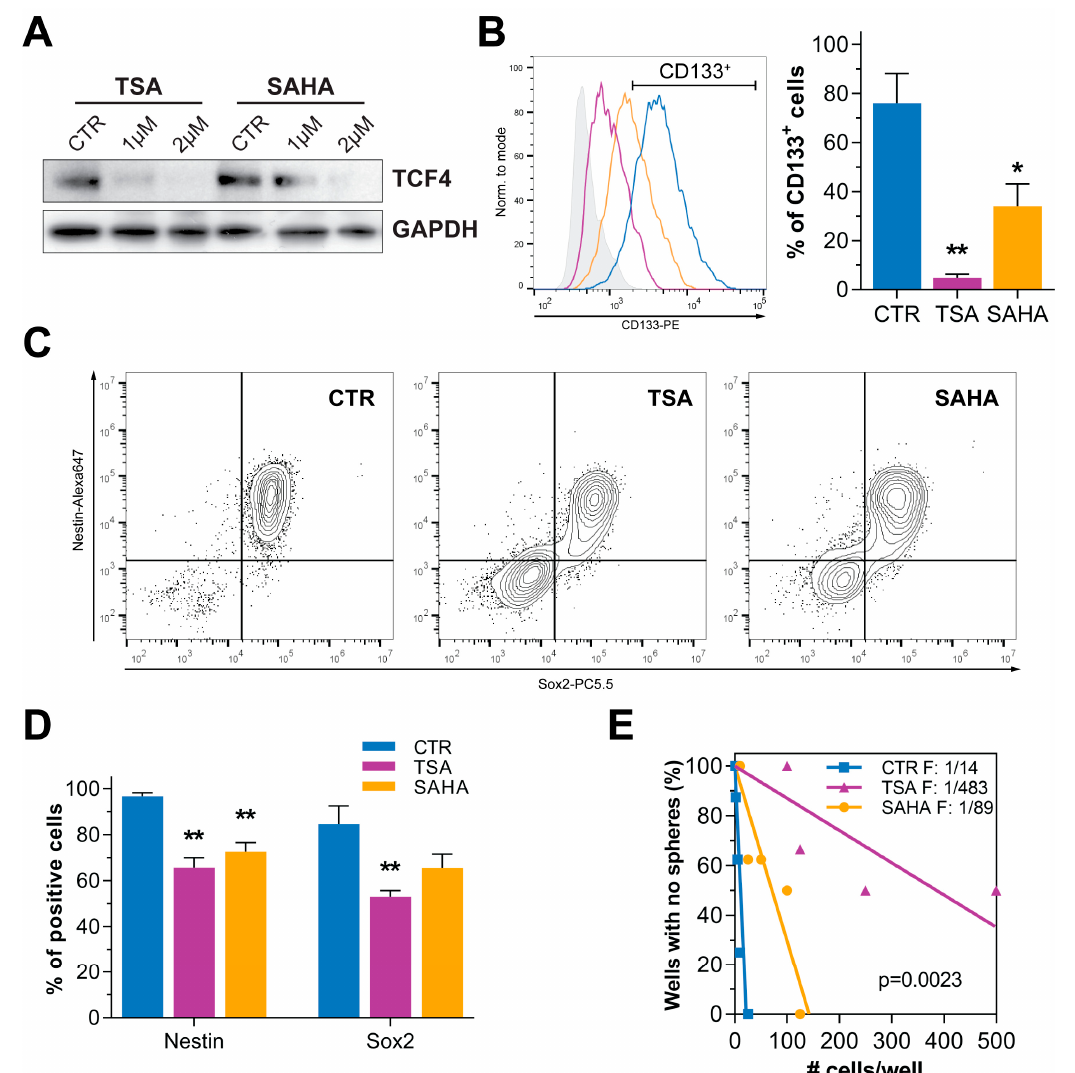
Figure 1. HDI treatment reduces TCF4 levels and impairs CSC phenotype and self-renewal. ( A ) West- ern blot analysis displaying TCF4 protein levels upon TSA and SAHA exposure (1–2 µ M) for 24 h (HuTuP53). GAPDH was used as loading control. The original Western blot images included in ( A ) are provided in Supplementary Figure S1A. ( B ) Representative CD133 surface expression in control and TSA (1 µ M)/SAHA (2 µ M) treated GBM cells (72 h; HuTuP197) (left) and graph sum- marizing quantification of CD133+ cells in 3 primary GBM cultures (mean of HuTuP13, 176, and 197) (right). ( C , D ) Representative contour plots displaying the combined expression of Nestin and Sox2 in HuTuP197 cells after 72 h of treatment with TSA (1 µ M) and SAHA (2 µ M) ( C ) and relative quantification of Nestin+ and Sox2+ cells in 3 different cell cultures (mean of HuTuP61, HuTuP176, and HuTuP197) ( D ). * p < 0.05, ** p < 0.01 by One-way ANOVA multiple comparison test. ( E ) Limiting dilution assay of GBM cells (HuTuP13) upon short-term exposure (24 h) to HDI (5 µ M). Initiating cell frequency of cells in each condition is reported. #: number ( F ) Western blot analysis displaying the levels of TCF4 expression in pcDNA3.1 and pcDNA3.1-TCF4 (Myc-tagged) transiently transfected GBM cells (HuTuP197). The original Western blot images included in ( F ) are provided in Supplemen- tary Figure S1D. ( G ) Bar graph summarizing quantification of CD133+ in GBM cells as in ( F ), treated with TSA (1 µ M) and SAHA (2 µ M) for 48 h. * p < 0.05, ** p < 0.01 by paired t test. These results agree with the anticipated hypothesis that HDI-mediated TCF4 inhibition could weaken the stem-like properties of GBM cells. In order to definitively support